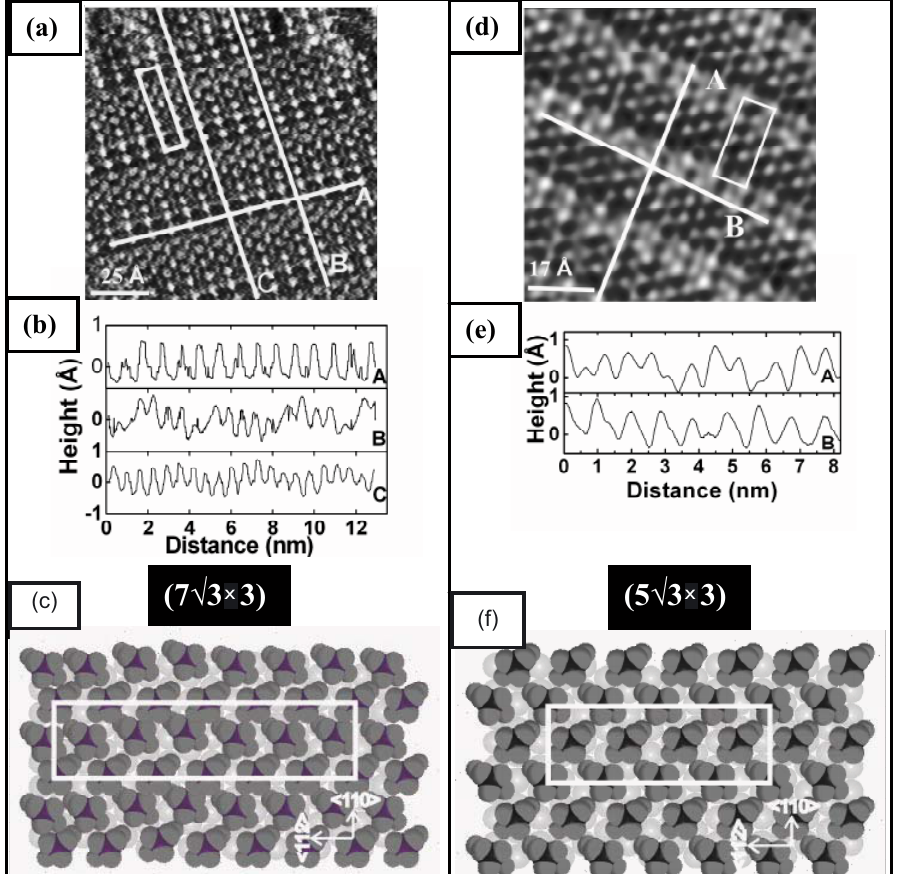
Figure 7. (a) and (d) constant-current STM images showing the gold surface after immersion into 100 μM ethanolic solution of BP2 at 348 K for 2 h. The unit cells of (7 √ 3×3) and (5 √ 3×3) structures are marked by the squares in (a) and (d), respectively; (b) and (e) cross-sectional height profiles along the lines A, B, C and A, B labeled in (a) and (d), respectively; (c) and (f) top views of (7 √ 3×3) and (5 √ 3×3) models, respectively. Tunneling parameters: (a) U= 450 mV; I= 137 pA and (d) U= 550mV; 150 long axis of the unit cell along the line A. In the line scan labeled B, which runs along the <110> direction, the intermolecular distances varied between 5 Å and 6.5 Å, with an average equal to 5.75 Å. Along the line labeled A, along the <112> direction, the intermolecular distance is equal to 20 Å. Therefore, the average distances between molecules along the <110> and <211> directions amount to 5.8±0.8 and 20±0.7 Å, respectively. The bases of ε-phase structure can, thus, be described as a rectangular (4√3×2) lattice. The unit cell consists of four molecules; therefore, the area per molecule equals 28.9 Å 2 . A schematic model showing the ε-phase structure is presented in Fig. 8i.